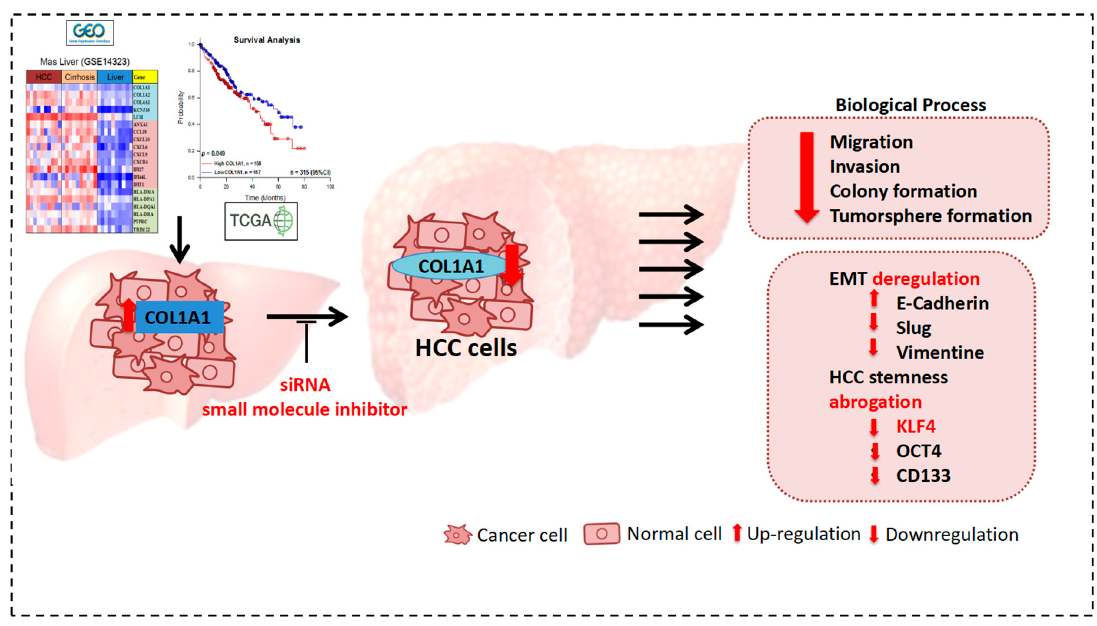
Figure 6. Pictorial abstract showing that the therapeutic or molecular targeting of COL1A1 function significantly impairs the oncogenicity and cancer stem cell-like phenotype of HCC cells by deregulating EMT and abrogating HCC stemness.